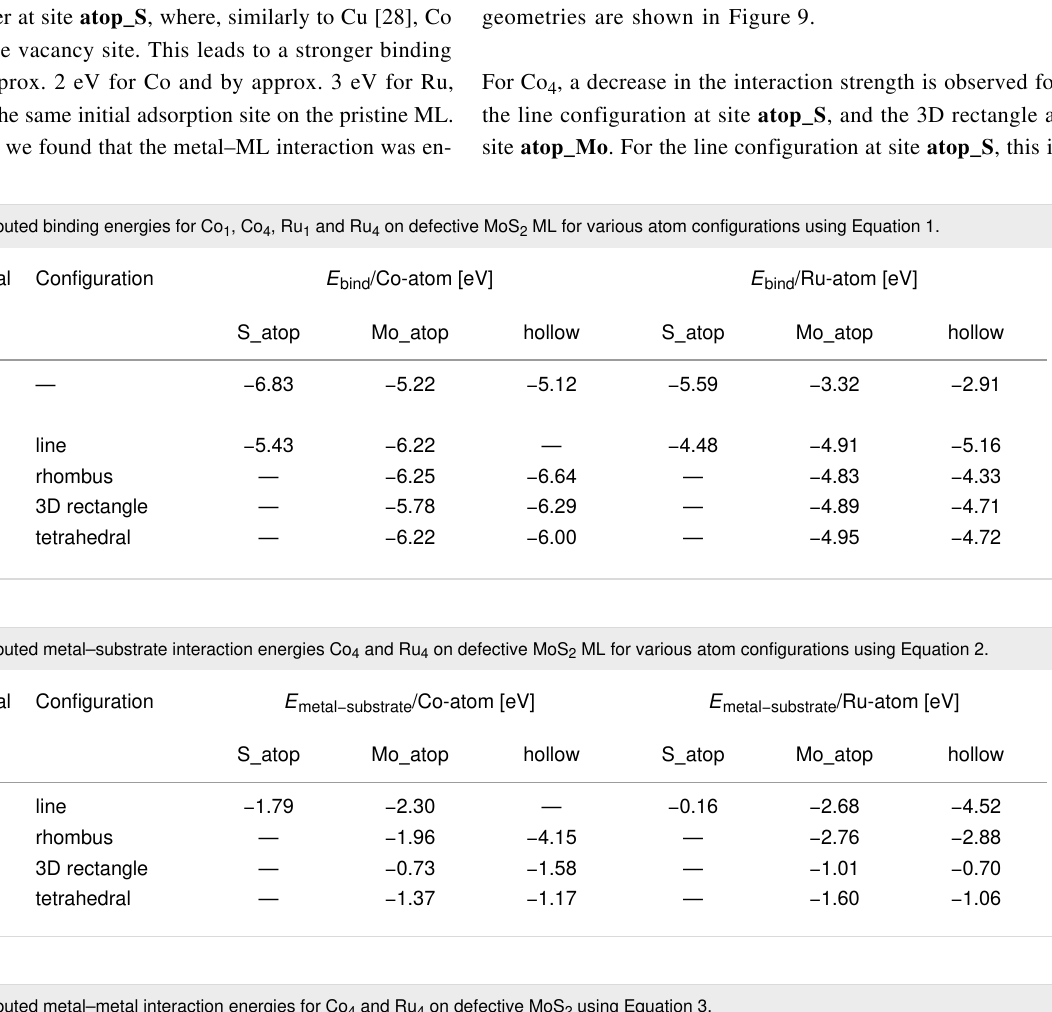
Table 6: Computed metal–metal interaction energies for Co 4 and Ru 4 on defective MoS 2 using Equation 3. No. of metal